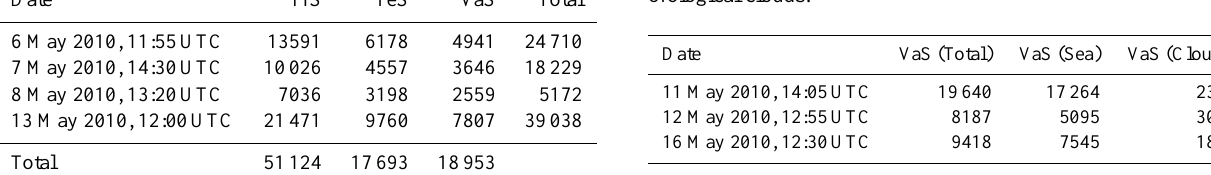
Table 3. Training, test and validation sets for the SO 2 retrievals. Table 4. Independent validation sets for ash parameters divided con- sidering the volcanic cloud over sea and volcanic cloud over mete- orological